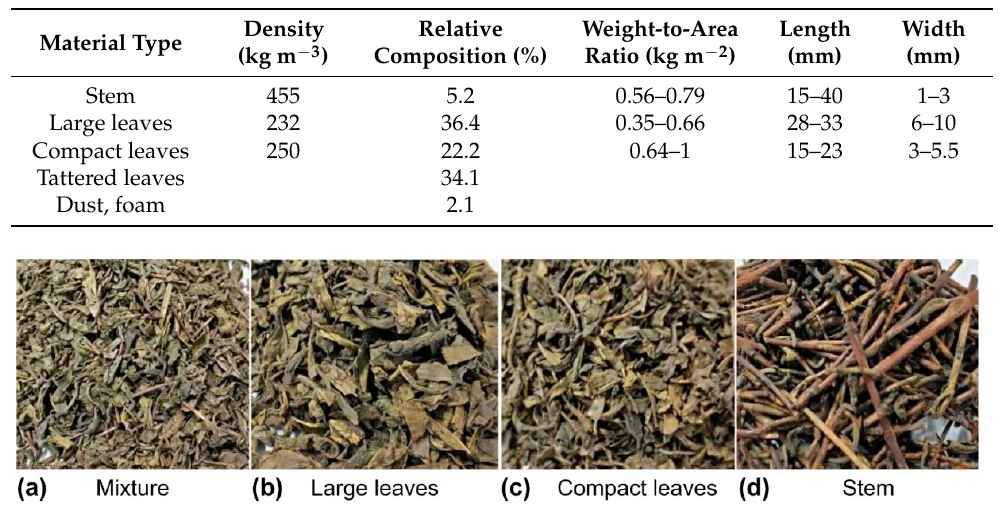
Figure 1. Composition of dried green tea.